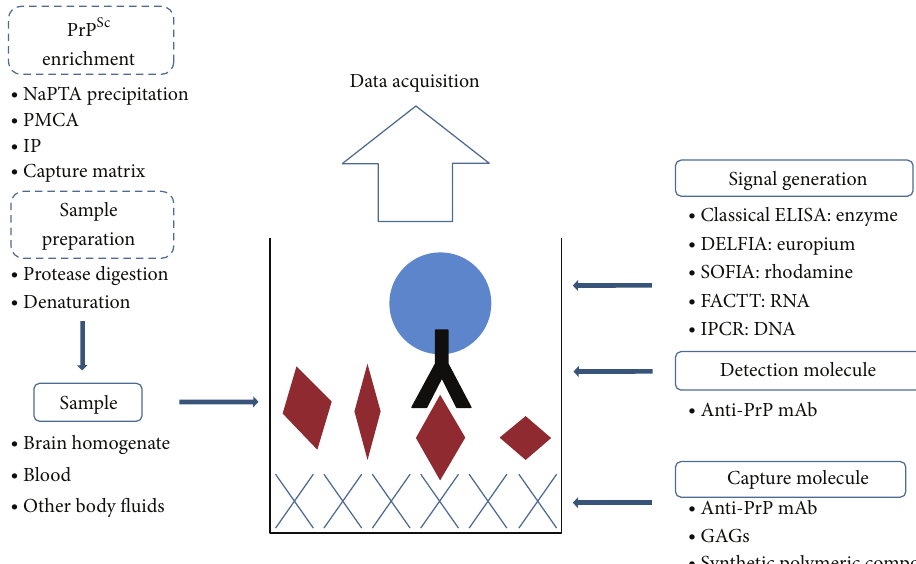
Figure 1: Schematic representation of described PrP Sc immunoassays. Dashed lines indicate optional steps of sample